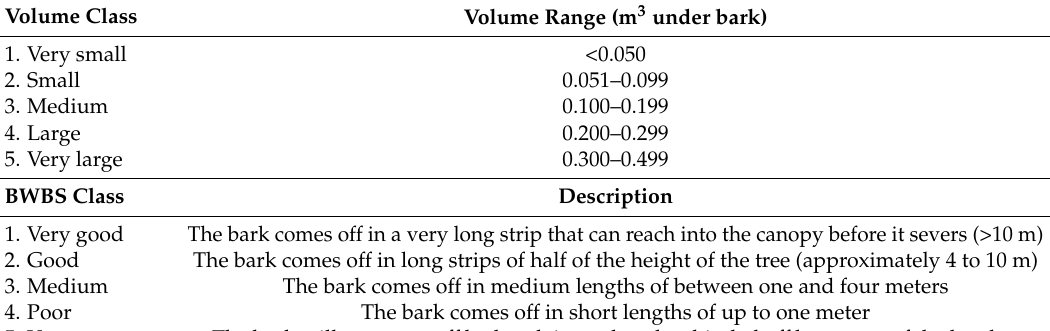
Table 2. Volume, bark–wood bond strength (BWBS), and work quality